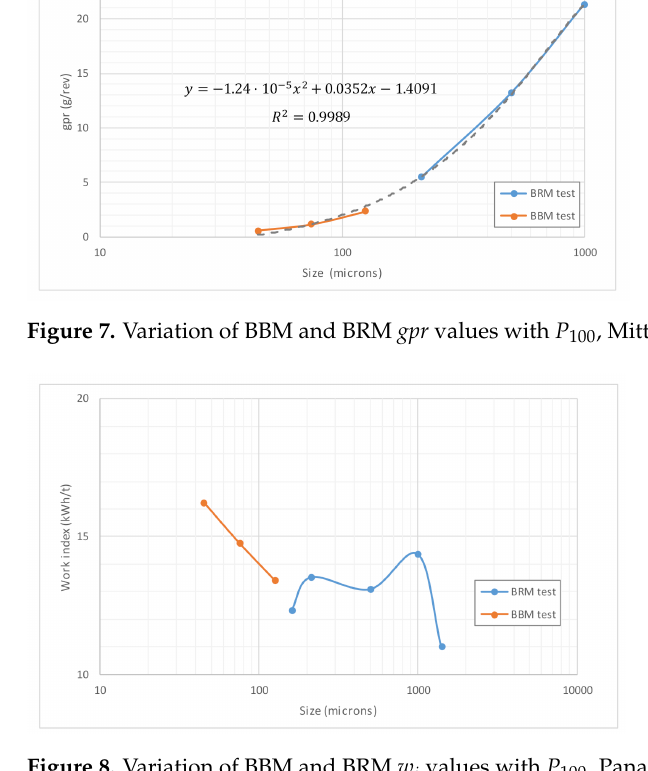
Figure 8. Variation of BBM and BRM w i values with P 100 , Panasqueira